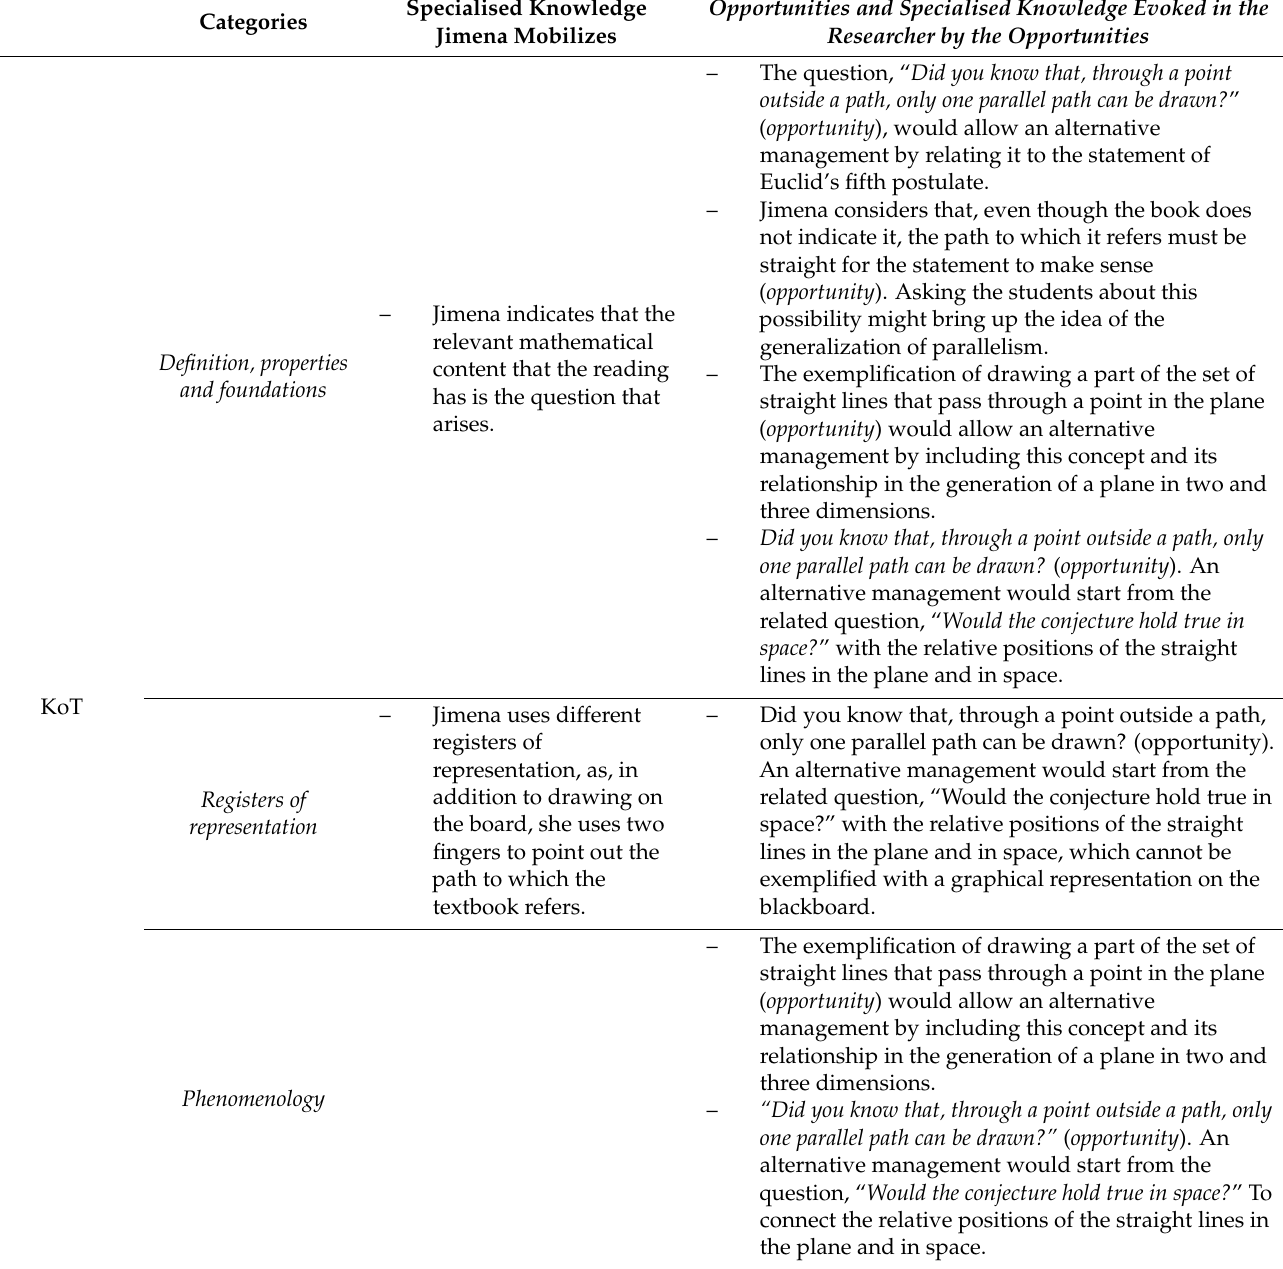
Table 4. Specialised knowledge to teach Euclid’s fifth postulate which emerges from Jimena’s session, in relation to the corresponding MTSK sub-domain and